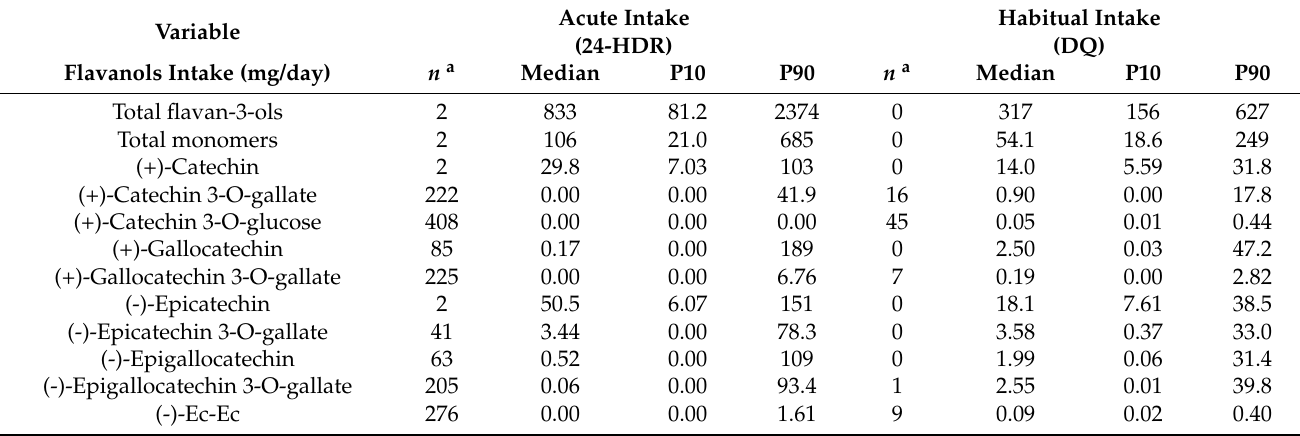
Table 2. Medians, and 10th (P10) and 90th (P90) percentiles of dietary intakes of flavan-3-ols, glycosides and aglycones and their main food sources in the European Prospective Investigation into Cancer and Nutrition (EPIC)